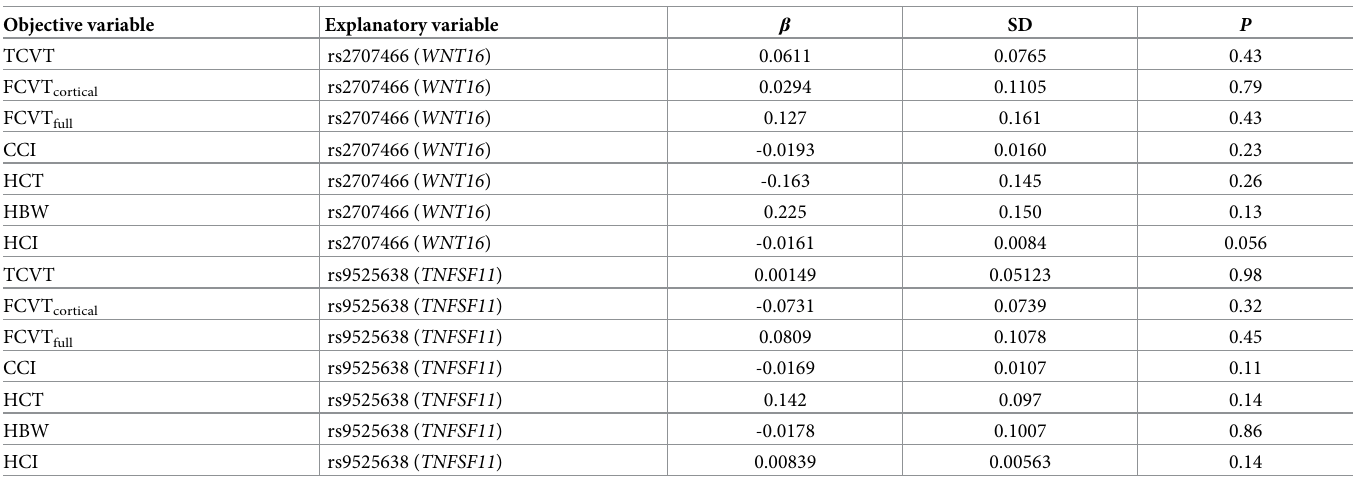
thickness via endosteal resorption occurring to a greater extent in females than males, primar- ily due to estrogen deficiency after menopause [24, 28, 29, 61]. Consistent with these observa- tions, our study showed that HBW increases with age and that there is no difference in the age-related increase in HBW between males and females (Fig 2 and Table 3). The age-related decline in HCT was greater in females than males. In addition, a negative correlation between HBW and HCI indicated that the proportion of the medullary cavity increases as bone width increases (Table 4). Only a few studies have examined age-related changes in CVT. These previous studies did not detect any significant age-related change in full CVT values in adults [33, 34]. Lillie et al. [35] reported a slight, but not significant, increase in full CVT with age and a significant decrease with age in the thickness of the inner and outer cortical tables. In the present study, we found a significant positive association between TCVT and age (Fig 2 and Table 2). In addi- tion, multiple regression analysis demonstrated that the age-related increase in TCVT was greater in females than males and that the age-related effect on FCVT also differed between full males and females. We also detected an age-related decrease in FCVT . Age-related cortical decreases in FCVT and HCT and age-related increases in TCVT and HBW suggest that cortical the cranial and long bones share common mechanisms of bone resorption along the endosteal surface and bone formation along the periosteal surface. However, it is notable that the age- related effect on FCVT did not differ with sex, in contrast to long bones. Therefore, post- cortical Table 7. Regression analysis examining the association of SNPs with bone